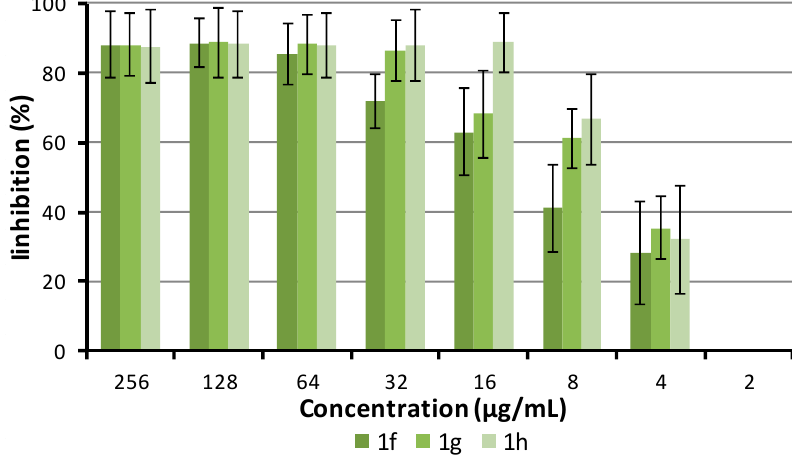
Figure 5. Disrupting effect of compounds 1f , 1g , and 1h on S. aureus ATCC 29213 biofilm formed. Clinically used local anesthetics (procaine, trimecaine, and tetracaine),